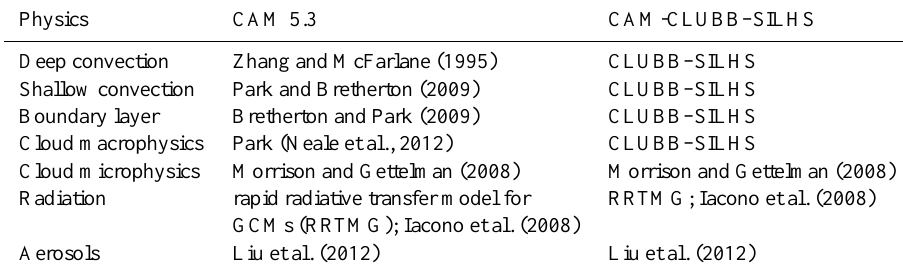
Table 1. Physical parameterizations in CAM 5.3 and CAM-CLUBB–SILHS